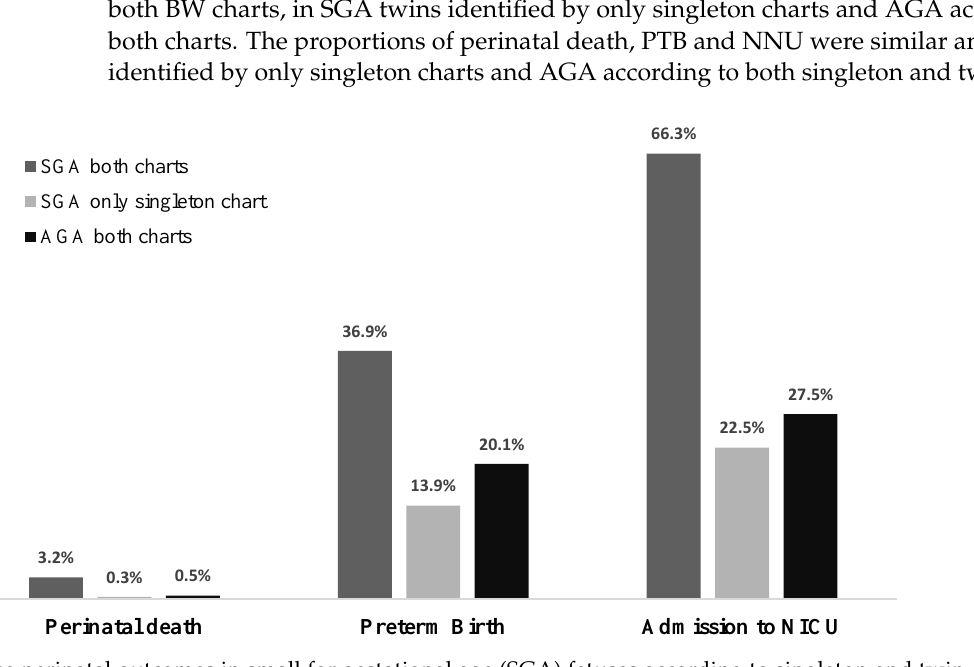
Figure 2. Adverse perinatal outcomes in small for gestational age (SGA) fetuses according to singleton and twin charts, SGA identified only by singleton chart and non-SGA (AGA) fetuses according to singleton and twin charts using birth weight.